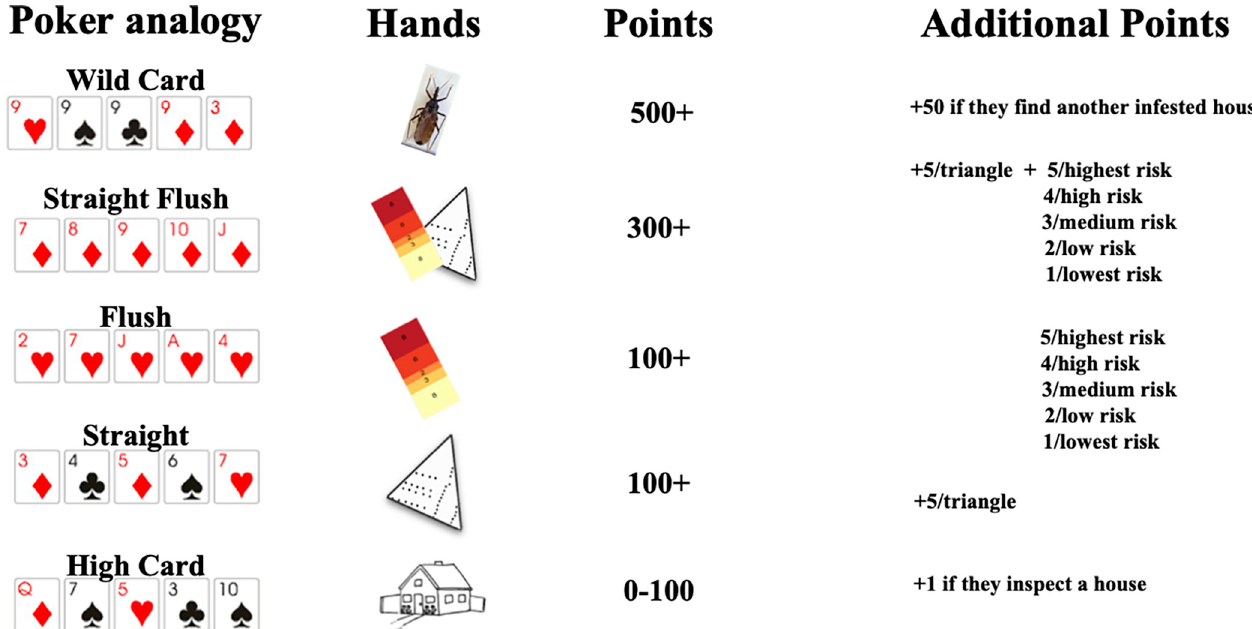
Fig 3. Poker incentive scheme. Column 1: Poker hands corresponding to each goal (i.e., different ways to earn points). Column 2: Images represent goals that participants could choose to achieve: Infested house detection (bug image), higher risk house inspections (five-color risk quintile image), and good spatial coverage (map image). The house image represents inspections regardless of house risk level or spatial coverage. Column 3: Base number of points for each hand. Column 4: Additional points (also referred to as ‘bonus points’) were awarded when participants exceeded the goals shown in the second column (details can be found in the poker hand descriptions in the text preceding the